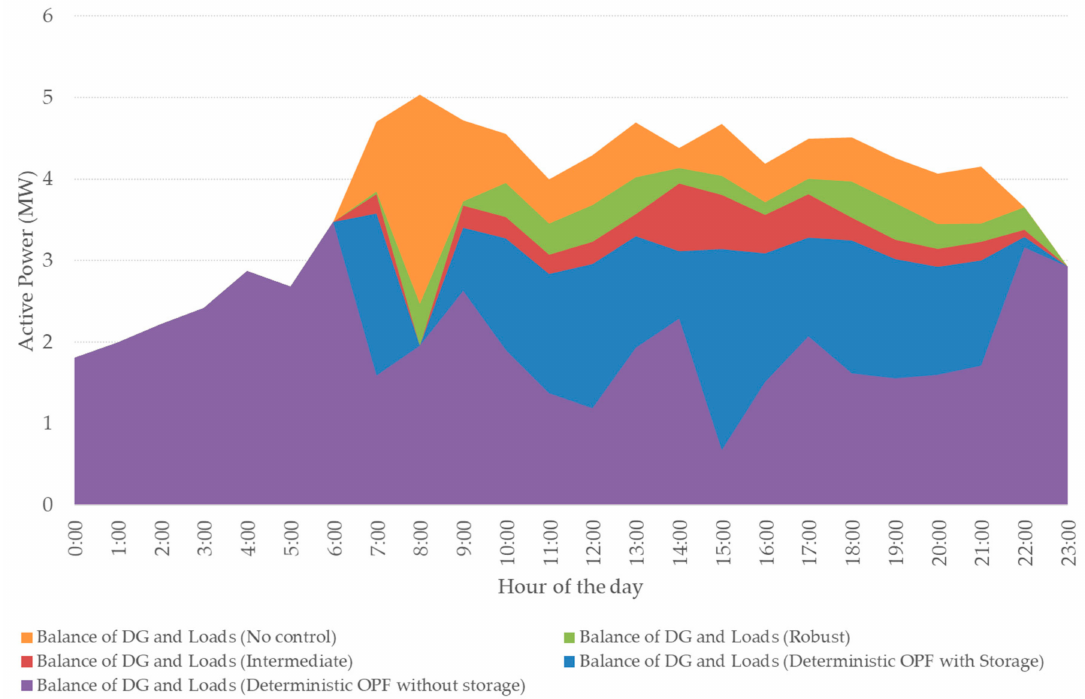
Figure 5. Balance of distributed generation (DG) production and curtailed demand of the feeder F1 for the no control, no storage (certain deterministic OPF without storage), deterministic (certain deterministic OPF with storage), intermediate and robust cases on the winter working day.